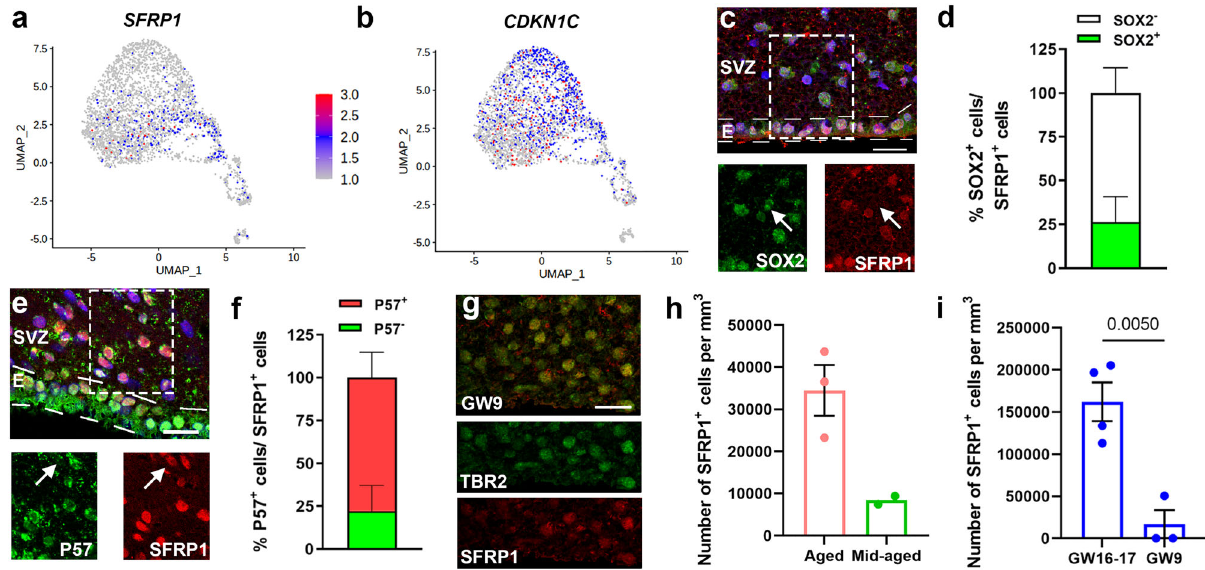
Fig. 4 Cell cycle inhibitors are expressed in the aged human SVZ. a , b Feature plot showing the expression of CDKN1C ( P57 ) ( a ) and SFRP1 ( b ) ( n = 3 donors; 2 females, aged 95 (504 cells) and 96 years (118 cells); 1 male, aged 72 years (116 cells)). c Representative image of SFRP1 + progenitors in the aged human SVZ. d Quanti fi cation of the percentage of SFRP1 + cells that express the stem cell marker SOX2 ( n = 3 donors). e Representative image of SFRP1 + and P57 + cells in the aged human SVZ. f Quanti fi cation of the proportion of SFRP1 + cells that express P57 ( n = 3 donors). g Representative images of SFRP1 + cells in the germinal region of the fetal human brain at GW9 co-expressing TBR2. h Quanti fi cation of SFRP1 + cells in the SVZ of aged ( n = 3 donors; 2 females aged 92 and 99 years, 1 male aged 82 years) and mid-aged ( n = 2 donors; 2 females aged 62 and 50 years) post-mortem brain tissue. i Quanti fi cation of SFRP1 + cells in the SVZ of GW9 ( n = 3 donors; 2 females, 1 male) and GW16-17 ( n = 4 donors; 2 females, 2 males) post-mortem brain tissue. Data represented as mean ± SEM when n > 2. Data represented as mean when n = 2. Two-tailed Unpaired Student ’ s t test. Hoechst was used as a nuclear counterstaining. E ependymal layer, GW gestational weeks. Scale bar = 20 µ m. Source data are provided as a Source Data fi